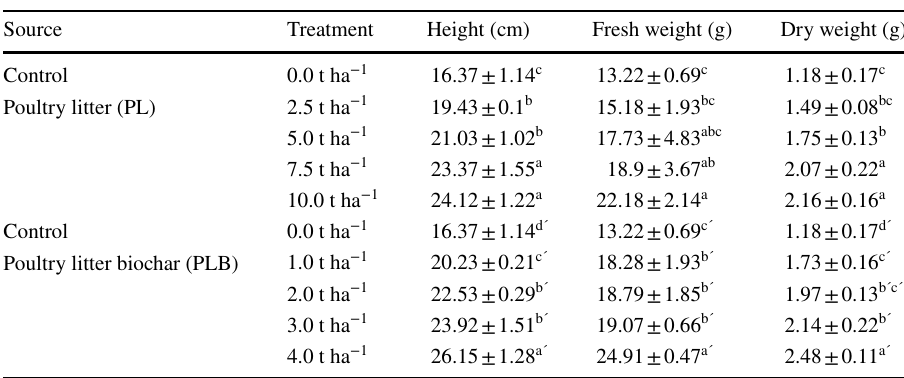
Data represent the average ± the standard deviation ( n = 3); different letters indicate the significant differ-